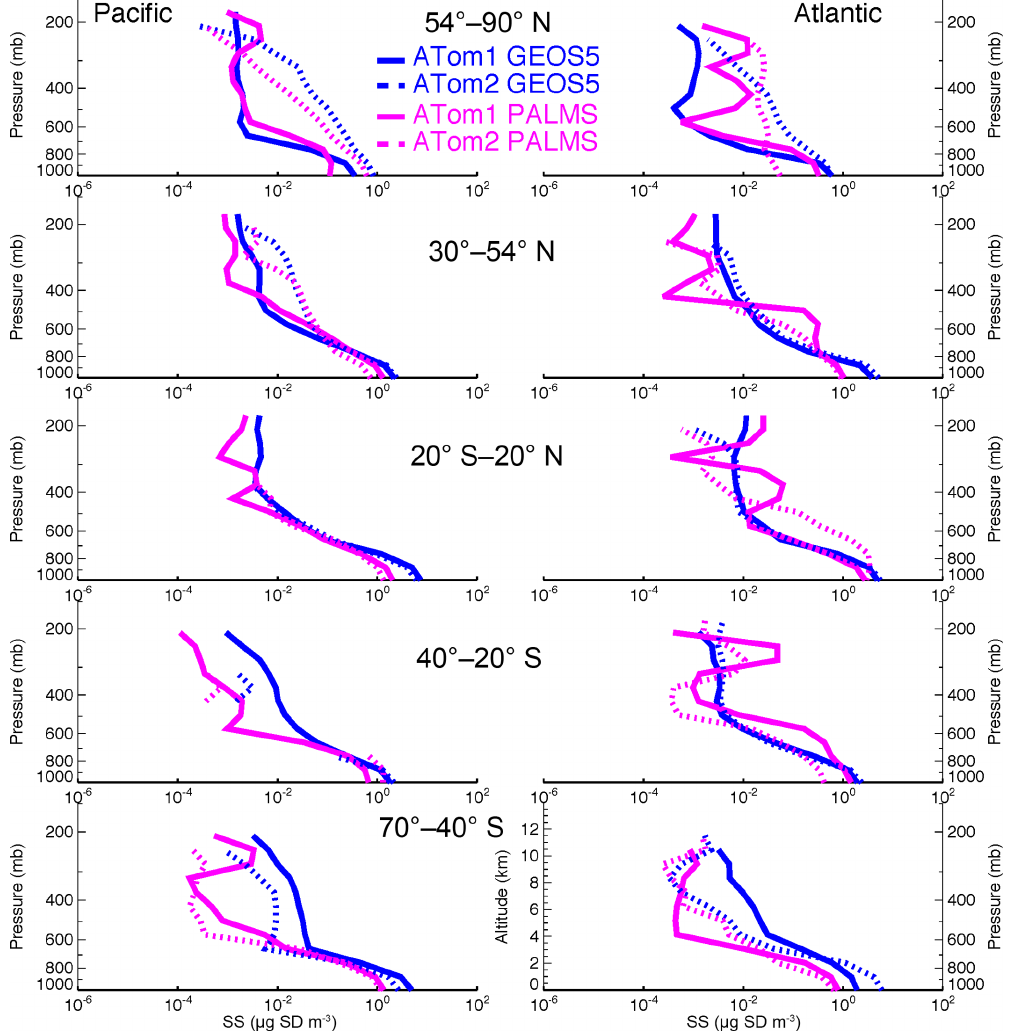
Figure 3. Sea salt ( D p < 3µm) vertical profiles from GEOS simulation and PALMS measurement along ATom1 and ATom2 flight tracks in five latitudinal bands over the Pacific and Atlantic oceans. The latitudinal bands are marked by dotted grey lines in Fig.